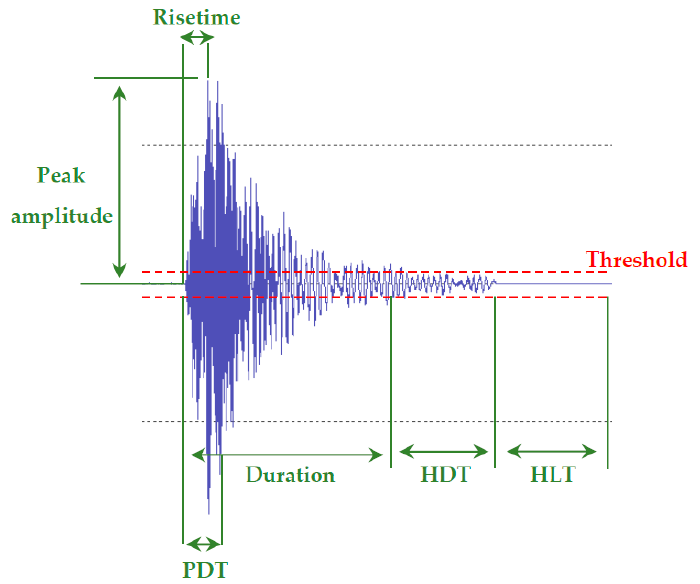
Figure 2. A schematic illustration of an annotated AE signal with appropriate parameters labelled (after [85]).